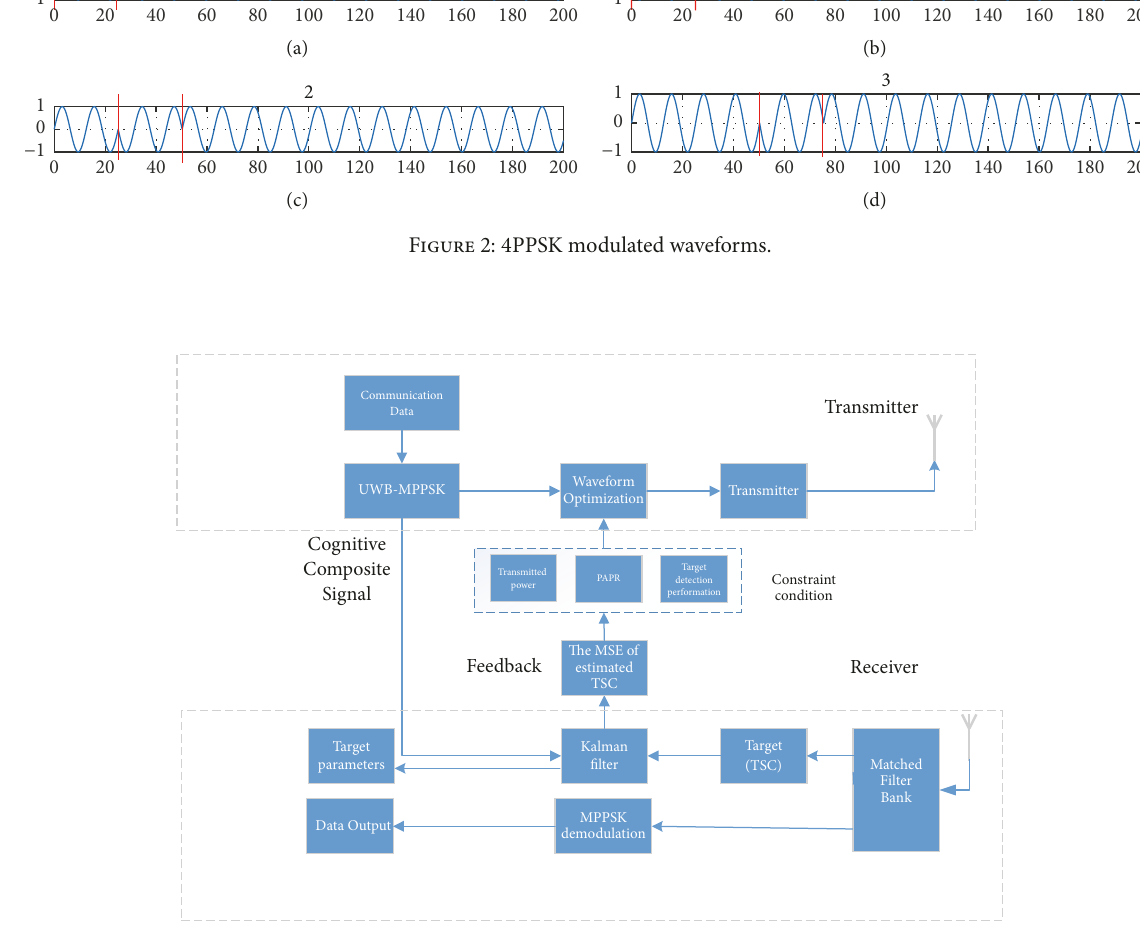
Figure 3: The system architecture of the CRC transceiver.